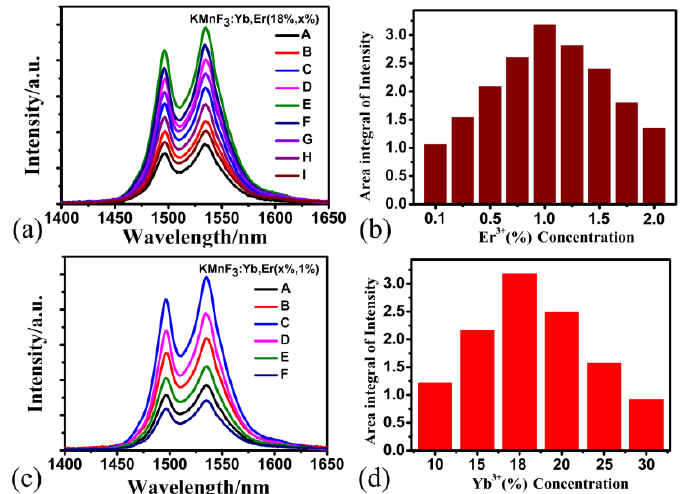
Figure 5. ( a ) Er 3+ ion concentrations dependent down-shifting fluorescence of KMnF 3 :18%Yb 3+ , x %Er 3+ ( x = 0.1, 0.25, 0.5, 0.75, 1, 1.25, 1.5, 1.75, 2) NPs (curves A–I) under 980-nm laser excitation; ( b ) enhancement ratio of down-shifting emission dependent on Er 3+ concentration of KMnF 3 :18%Yb 3+ , x %Er 3+ NPs; ( c ) Yb 3+ ion concentrations dependent down-shifting luminescence of KMnF 3 : x %Yb 3+ ,1%Er 3+ ( x = 10, 15, 18, 20, 25, 30) NPs (curves A–F) under 980-nm laser excitation; ( d ) enhancement ratio of down-shifting emissions dependent on Er 3+ concentrations of KMnF 3 : x %Yb 3+ ,1%Er 3+ NPs.